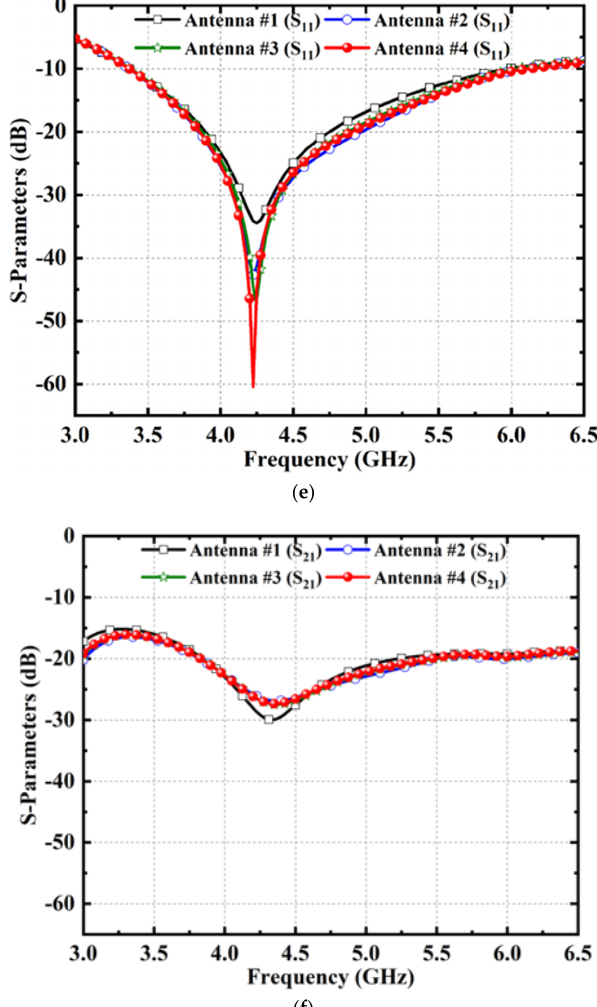
Figure 3. ( a – d ): Two-element MIMO antenna evolution stages, ( e ) S 11 response of all stages, and ( f ) S 21 response of all stages.